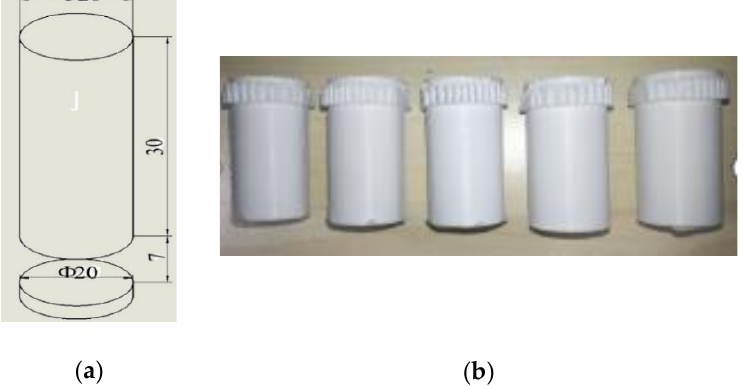
Figure 1. DF-G450 working principle diagram. Figure 2. Experimental sample: ( a ) test-piece 3D model diagram; ( b ) photograph of some of the test pieces.